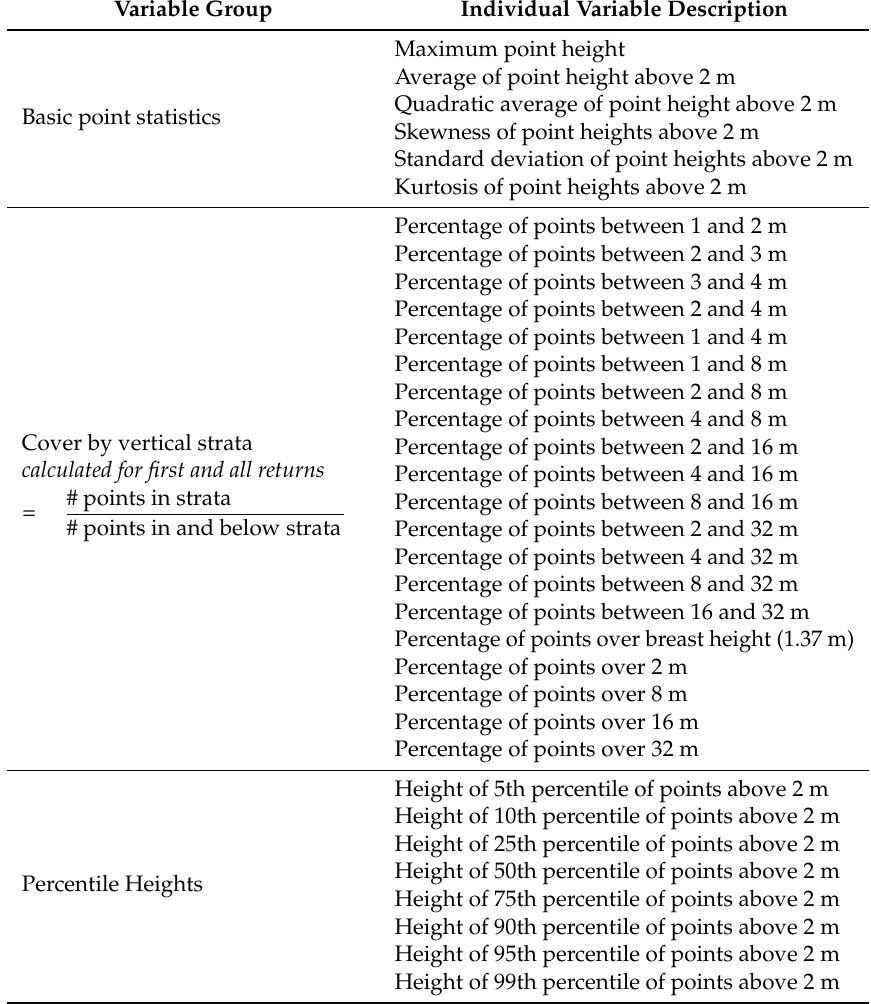
Table A2. Details each LiDAR-derived